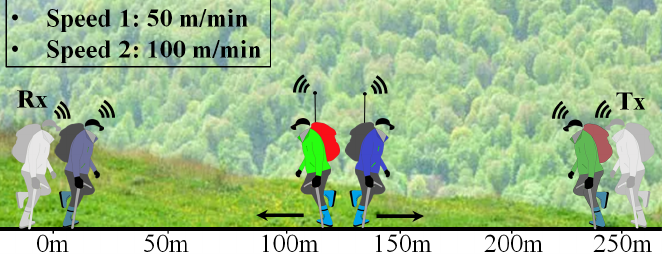
Figure 8. Two mobile nodes